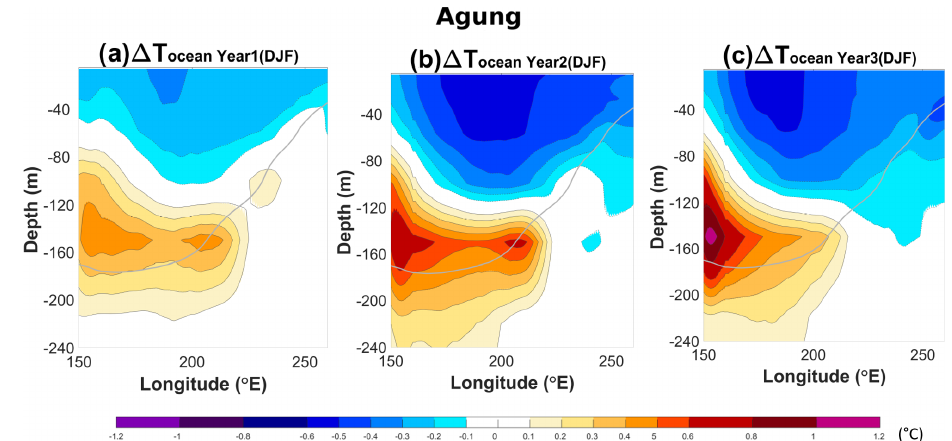
Figure A14. Ensemble mean changes shown for a transect in the equatorial Pacific (averaged 5 ◦ N–5 ◦ S) of the ocean temperature (shadings) between the volcano case and the climatology for each of the following three winter seasons (DJF) after the Agung eruption. Contours show the SST anomalies following the colour bar scale (solid lines for positive anomalies and dashed lines for negative anomalies; the 0 line is omitted). The bold grey line shows the climatological thermocline depth (as defined using the 20 ◦ C isotherm). This is shown for 100 ensemble